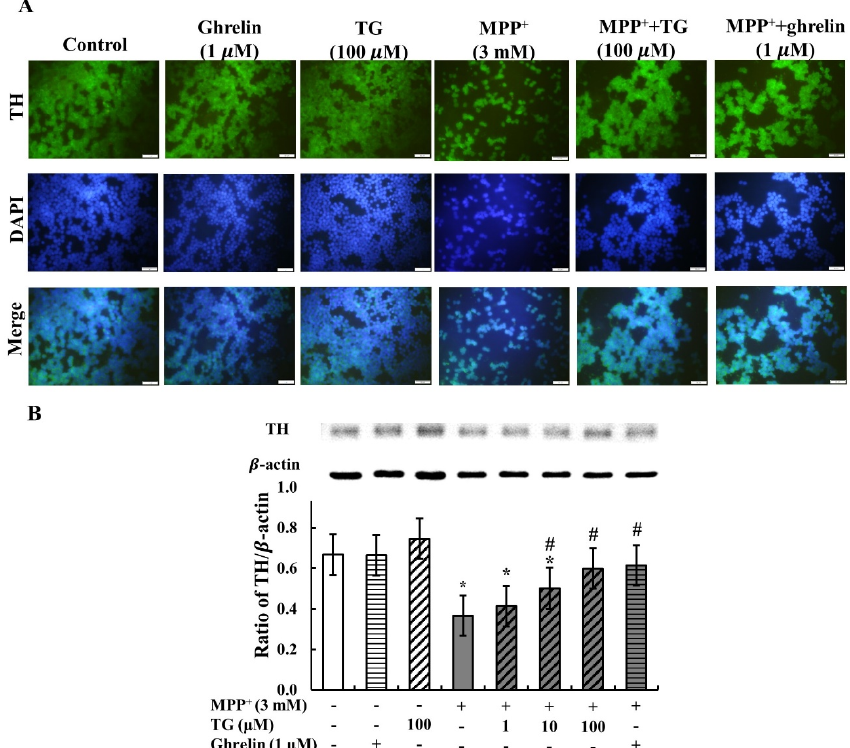
Figure 3. Teaghrelin (TG) attenuated 1-methyl-4-phenylpyridinium (MPP + )-induced loss of tyrosine hydroxylase (TH) expression in SH-SY5Y cells. ( A ) Immunofluorescence staining of tyrosine hydroxylase (green) and DAPI (blue) in each group of SH-SY5Y cells with various treatments (scale bar, 50 µ m). ( B ) SH-SY5Y cells treated with or without TG, ghrelin, and MPP + for 24 h. The expression of TH was analyzed through Western blotting. The expression of β -actin was used as the internal control. The results were analyzed through one-way analysis of variance. Values are presented as the mean ± standard deviation ( n = 3). * p < 0.05 compared with the control group, # p < 0.05 compared with MPP + alone. -: untreated with drugs or compounds, + : treated with drugs or